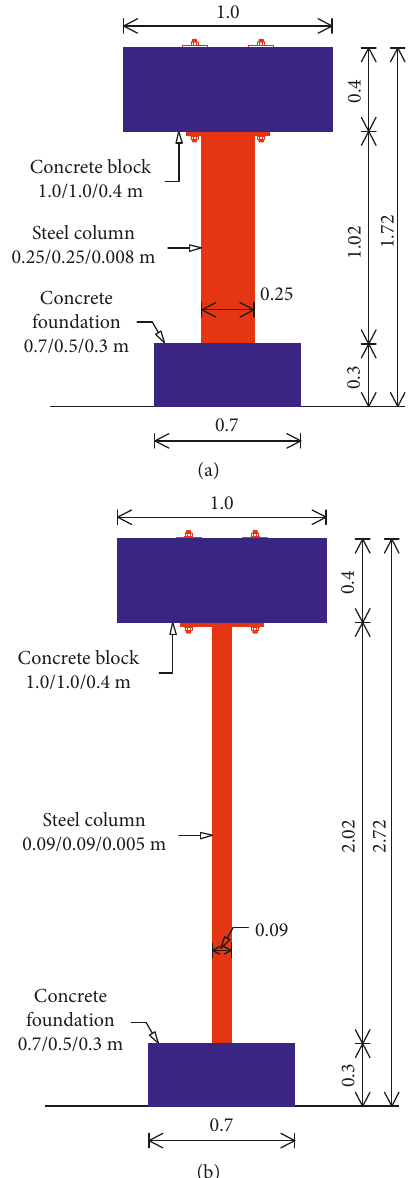
Figure 4: Considered building models. (a) MSB ( T MSSB ( T 0.60s). (cid:31)